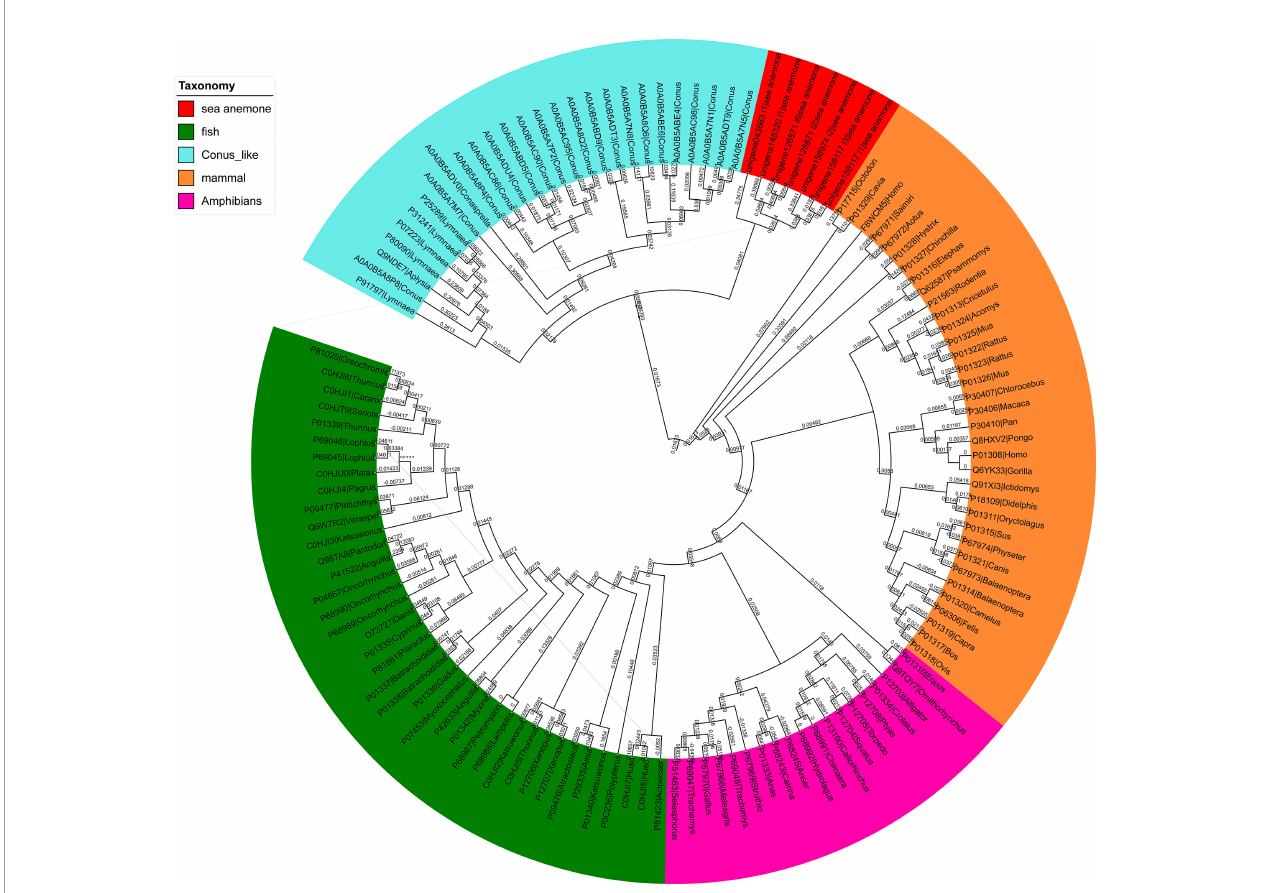
FIGURE 10 | A phylogenetic analysis of the insulin-like peptides (ILPs) from different species. The tree was built via the NJ method. The reliability of every branch was evaluated using 1000 bootstrap